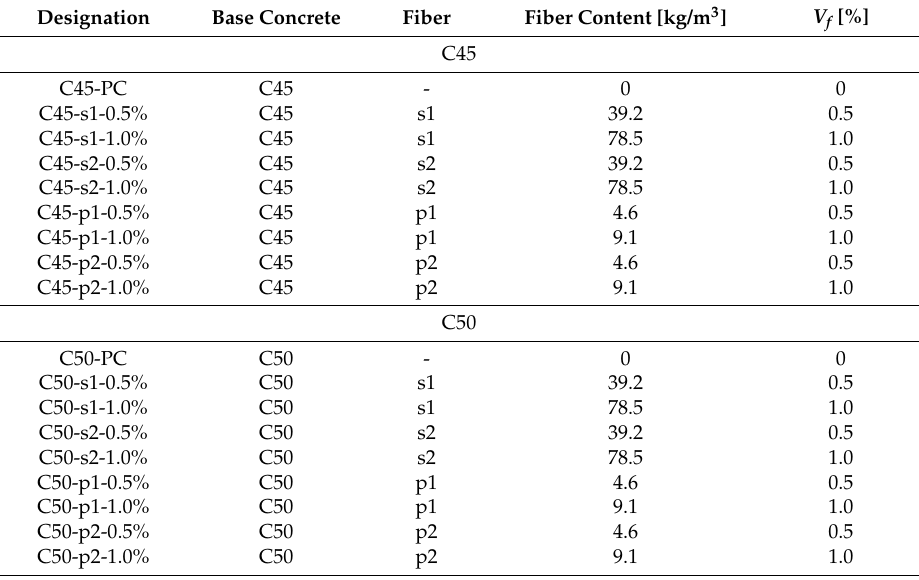
Table 3. Concrete designation and fiber